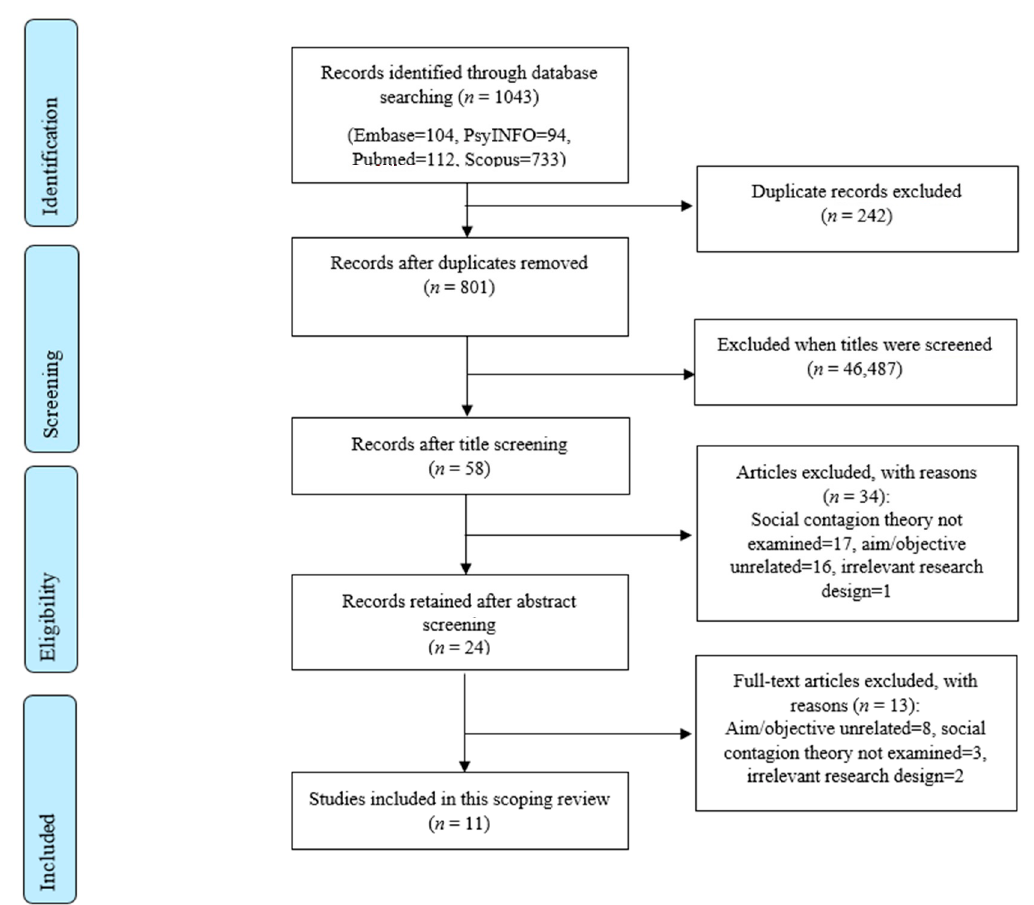
Figure 1. Flow diagram of information detailing the database searches, the number of titles and abstracts screened and excluded, and the full texts retrieved and excluded.